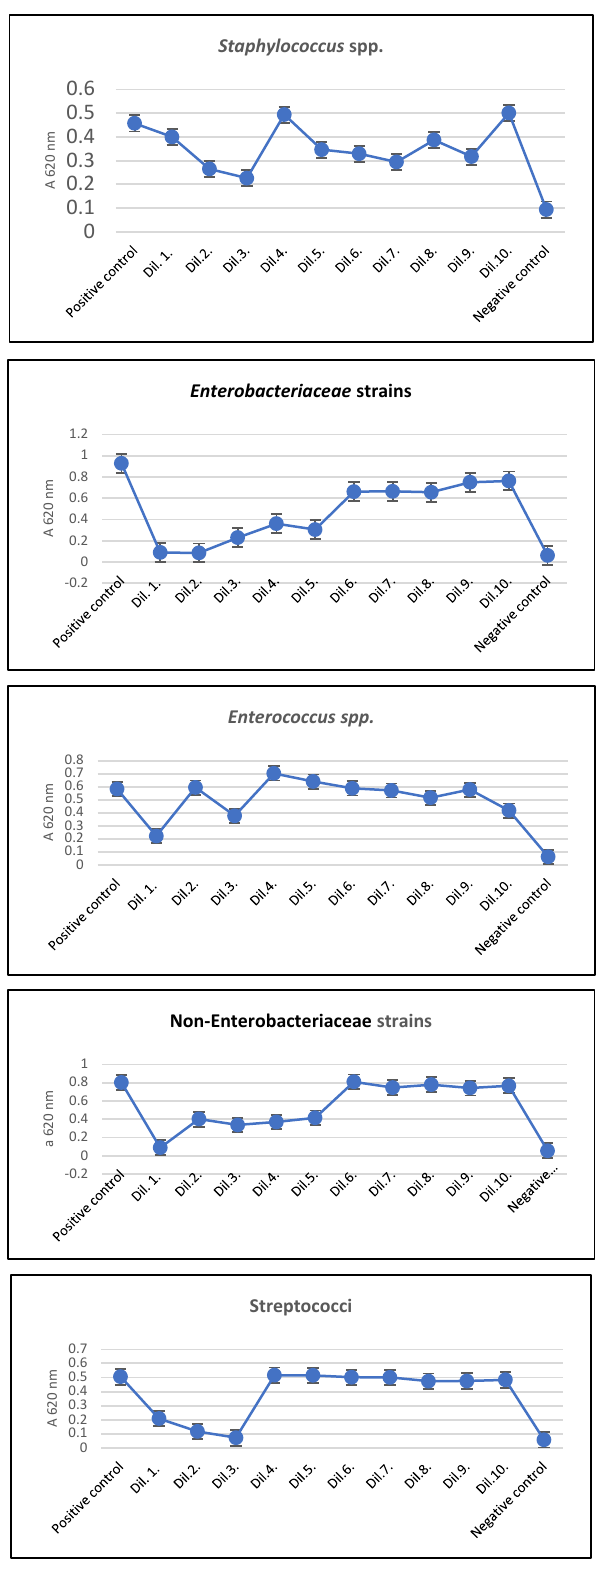
Figure 2. Graphic representation of planktonic growth dynamics (expressed as average value of absorbances obtained for different strains) in the presence of binary concentrations of 1/6000 silver so- lution for the analyzed strains (Dil.1.–10.-tested binary concentrations) (average value of absorbances obtained for the tested strains are